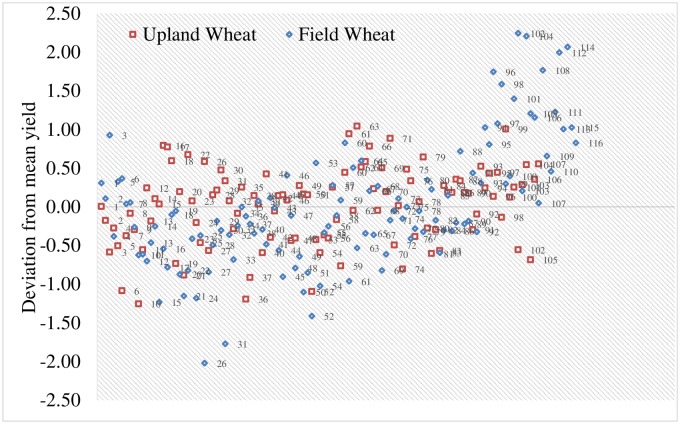
Mean genetic deviations obtained in the first cycle.